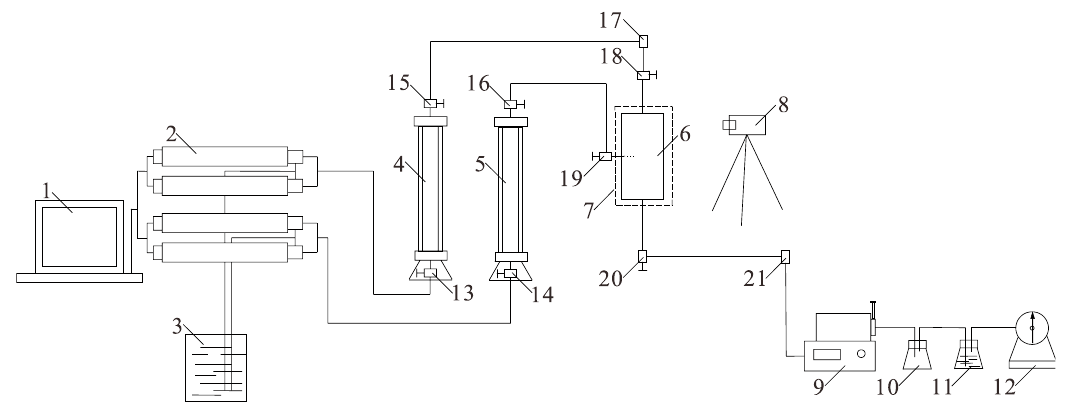
Figure 2. Experimental flow chart.1: computer operating terminal; 2: Quizix qx5210 high-pressure